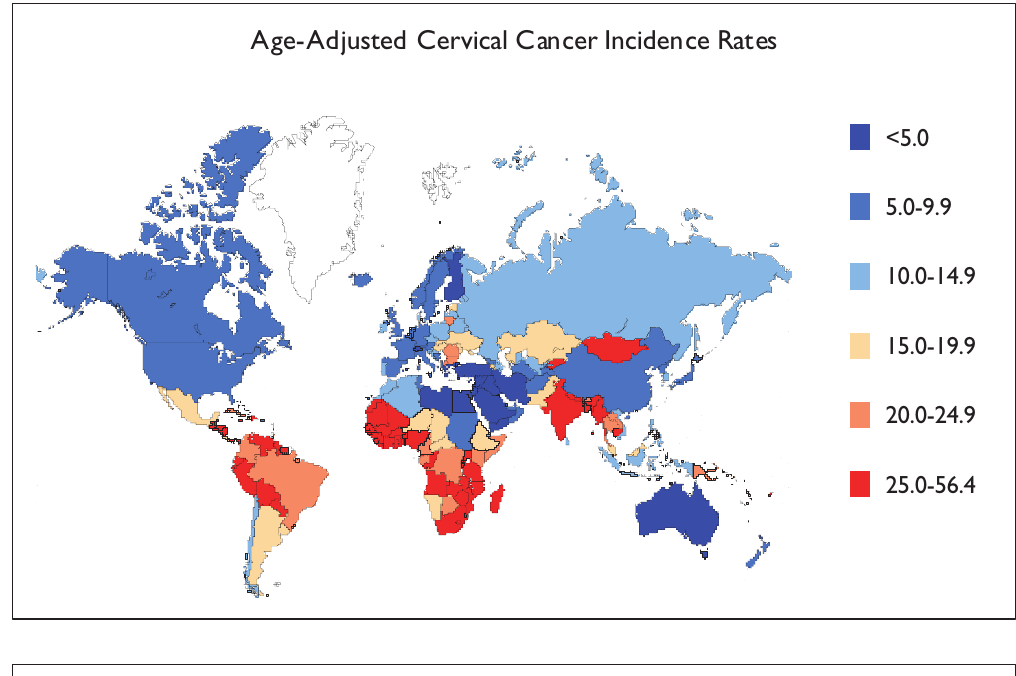
Figure 1. International Variations in Age-Adjusted Cervical Cancer Incidence and Mortality Rates per 100,000 World Standard Population,